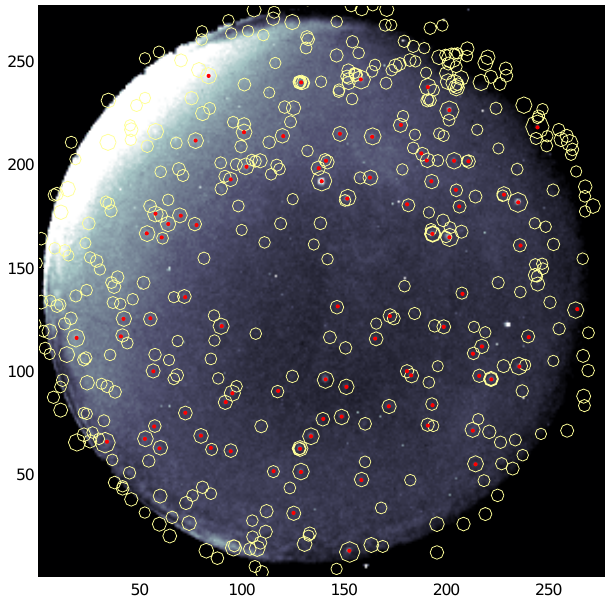
Fig. A2. Calibration image from the HAARP all-sky imager with overlayed stars, those used to determine camera rotation and intrin- sic camera model parameters marked with red dots.